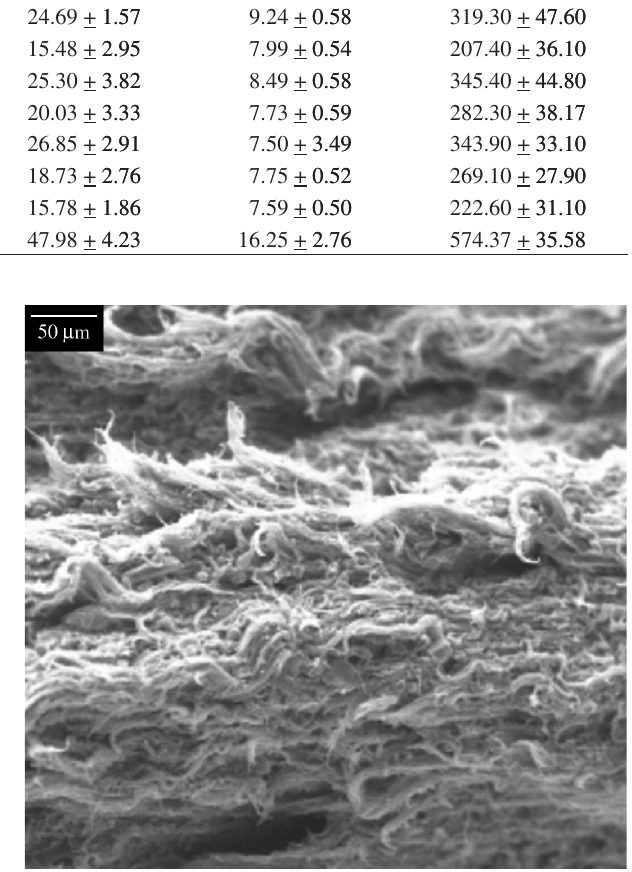
Figure 2. Typical aspects of the fracture surface of the recycled EVA sam- ples.